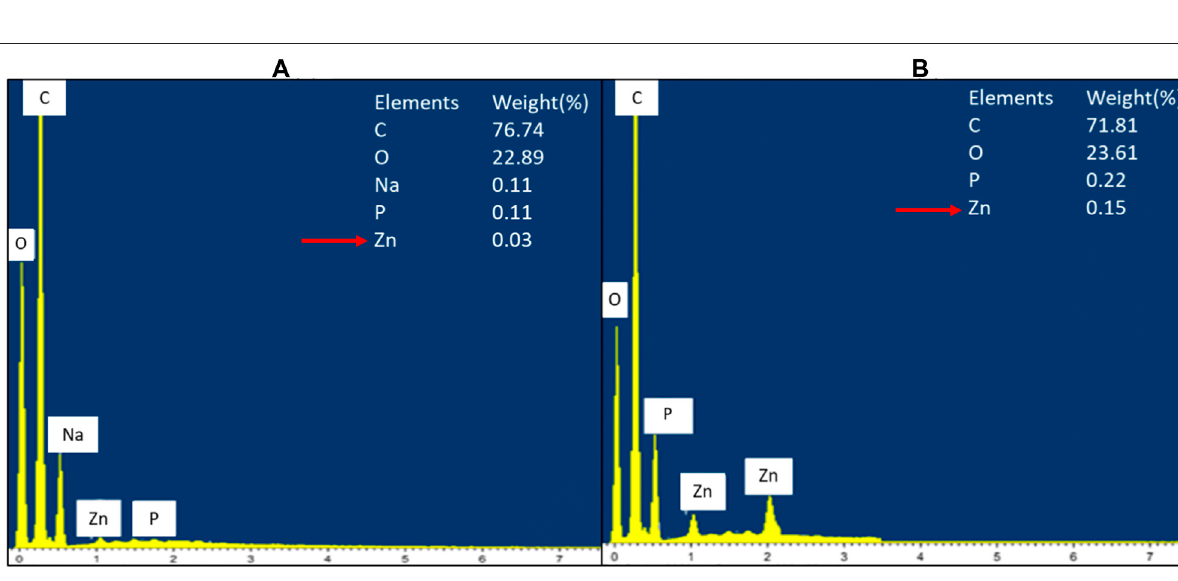
Frontiers in Pharmacology |